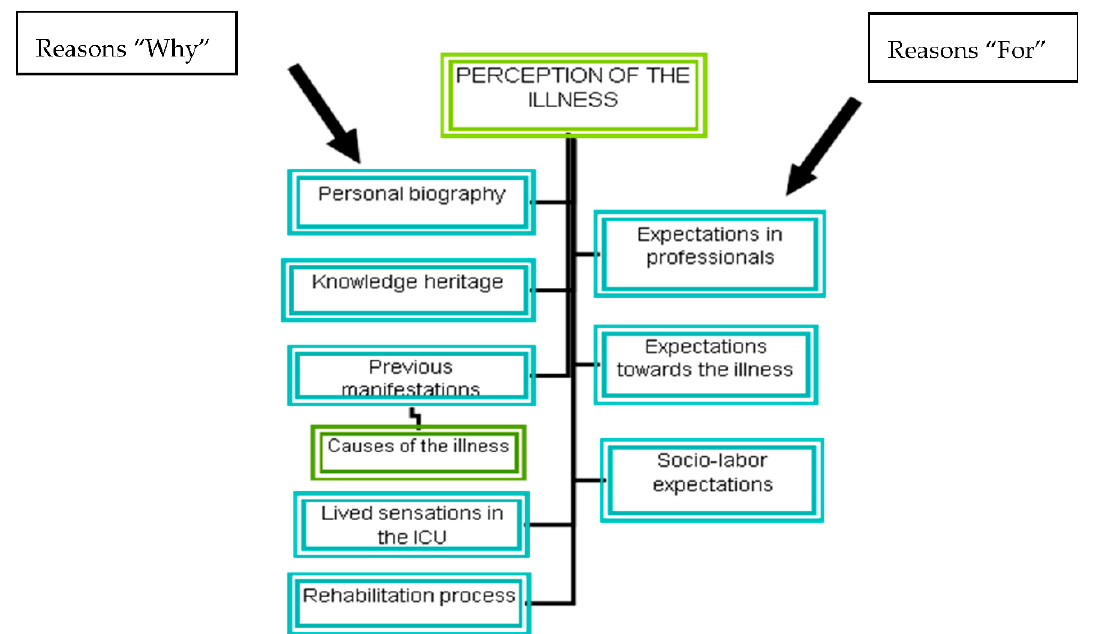
Figure 1. Analysis of the content according reasons “why” and reasons “for”.